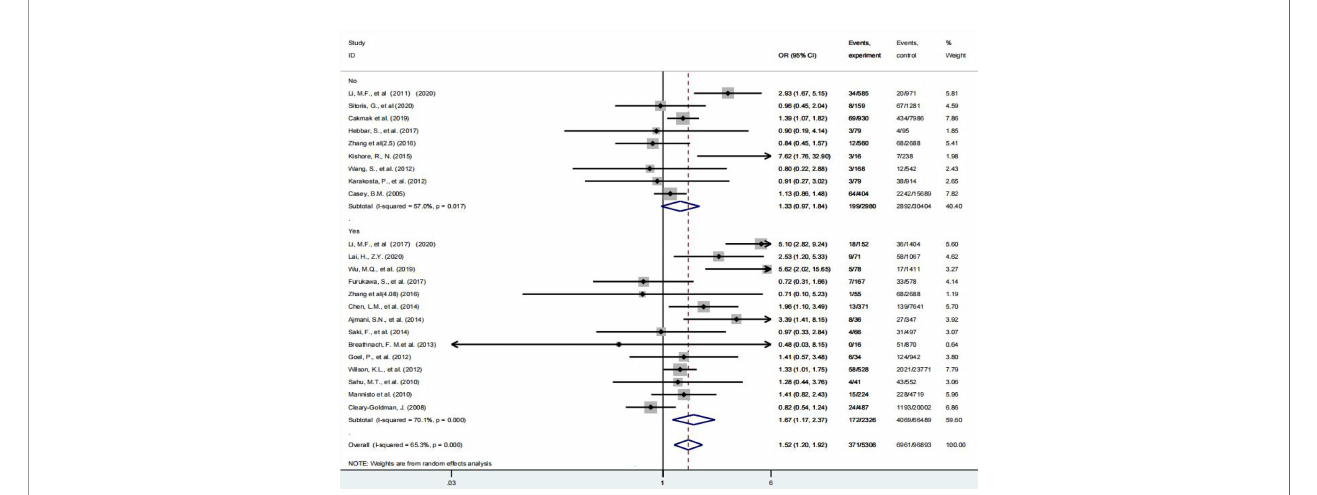
FIGURE 3 | Forest plot of relative risk and 95% CI of pooled studies comparing pregnant women with subclinical hypothyroidism to euthyroid pregnant women for risk of HDP that used a TSH upper limit of 3.0 mIU/L. and (B) that used a TSH upper limit of 4.0